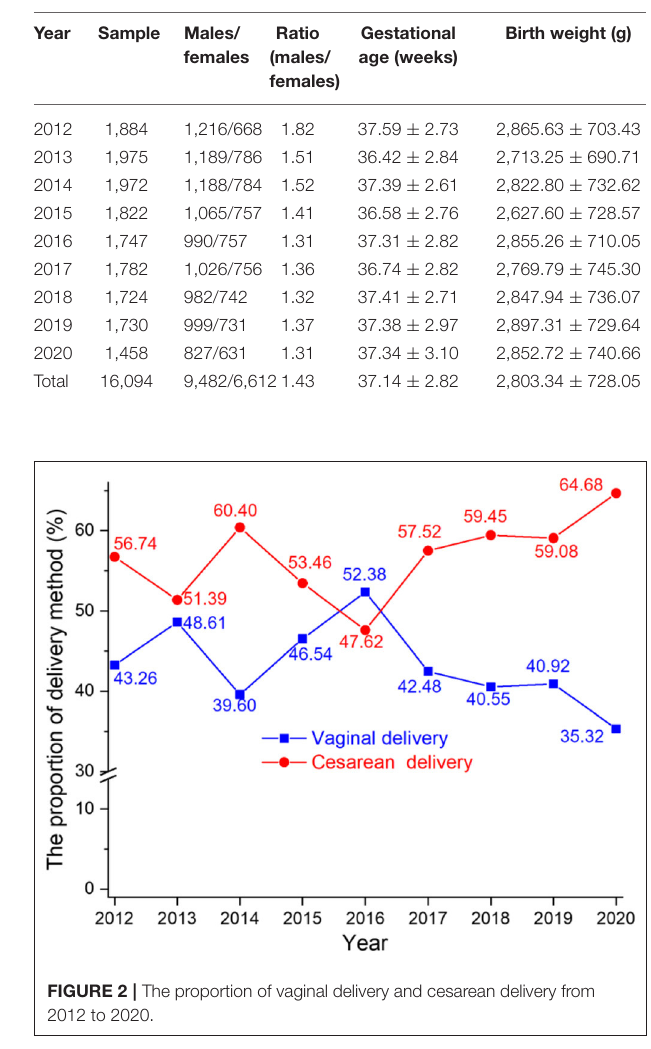
TABLE 4 | Basic information about hospitalized newborns from 2012 to 2020.